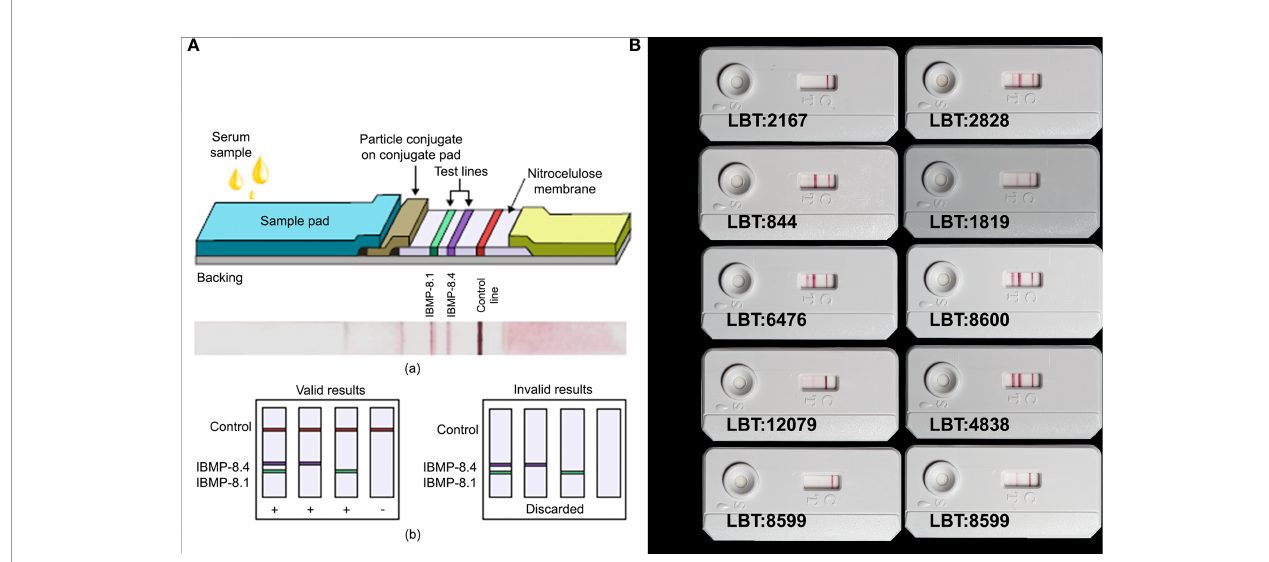
FIGURE 2 | (A) Lateral fl ow assay (LFA) device. (a) Schematic illustration of the composition of the LFA strip for the detection of IgG anti- Trypanosoma cruzi in samples employing the IBMP-8.4 and IBMP-8.1 chimeric antigens and photographic image of an LFA opened device after loading T. cruzi -speci fi c IgG antibodies. (b) Schemes of the results expected for valid and invalid results yielded by LFA. Copyright © Silva et al., 2020, https://doi.org/10.1155/2020/1803515. (B) Canis lupus familiaris : LBT 2167 (-), LBT 2828 (+), LBT 844 (+; DTU TcI), LBT 1819 (+; DTU TcI/TcII), LBT 6476 (+; DTU TcIII), LBT 8600 (+; DTU TcIII/V), LBT 12079 (+; DTU TcIV); Canis lupus : LBT 4838 (+); LBT 8599: sample from a domestic dog with seroconversion event (2009 and